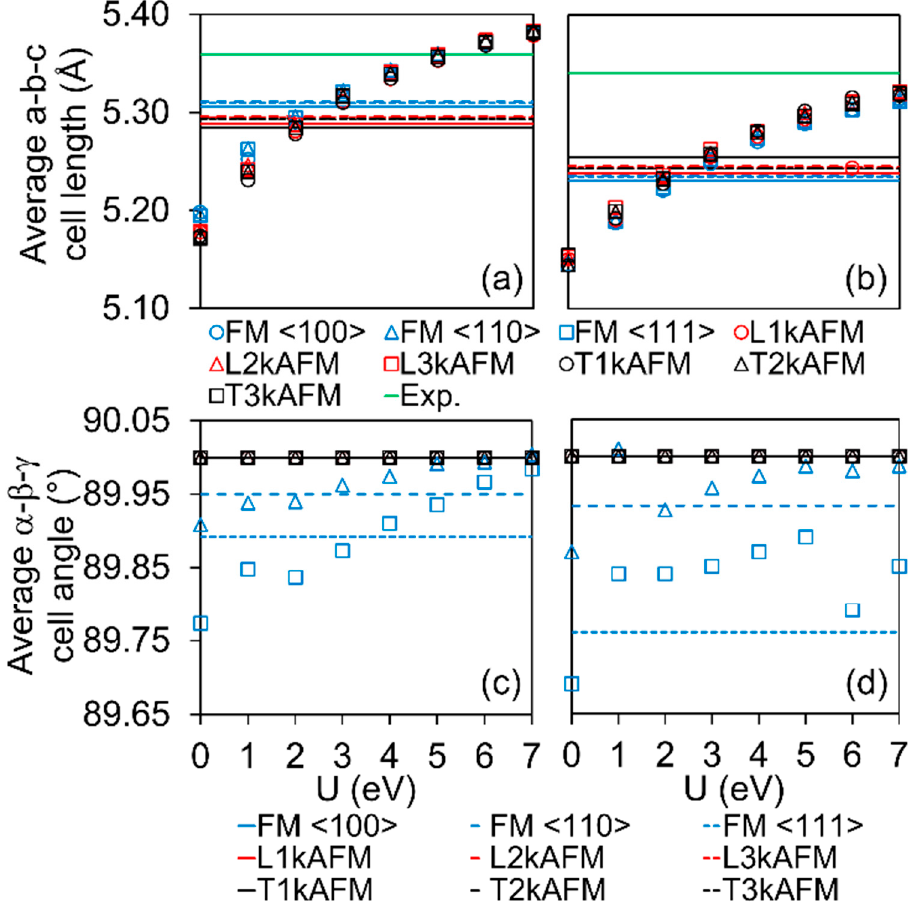
Figure 5. Average cell lengths a-b-c (Å) for cubic ( a ) PuH 2 and ( b ) PuH 3 and average cell angles α - β - γ (degree) for ( c ) PuH 2 and ( d ) PuH 3 . Where PBEsol+ U +SOC ( U = 0–7 eV) method is represented by circles, triangles and squares symbols for <100>, <110> and <111> alignments, respectively, and HSE06sol+SOC method is represented by solid, dash and square dotted lines for <100>, <110> and <111>, respectively. FM in blue, LAFM in red, TAFM in black. Experimental cell lengths represented in green for PuH 2 (Mulford et al. [49,50]) and PuH 3 (Muromura et al. [29]).